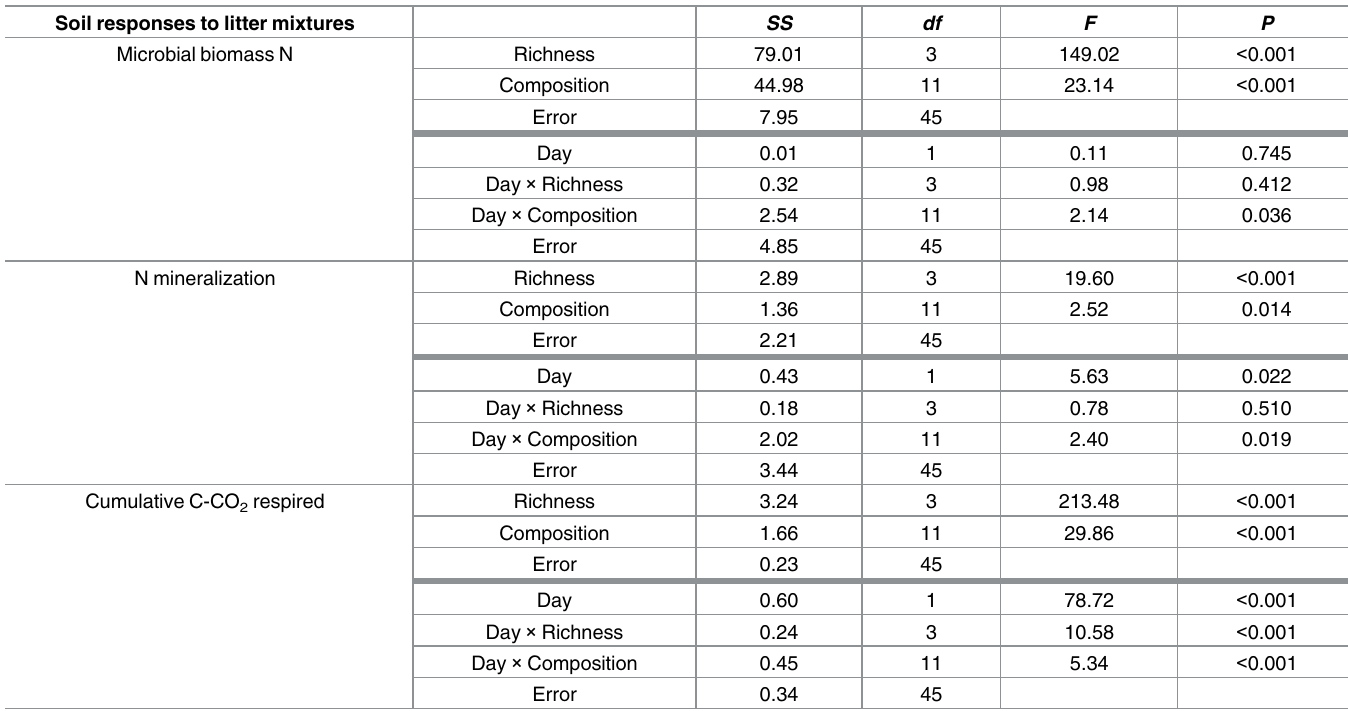
Table 4. Summaryof the ANOVA’s test to evaluate if richness and/or composition influence the non-additive effectsof species mixing. Soil responses to litter mixtures